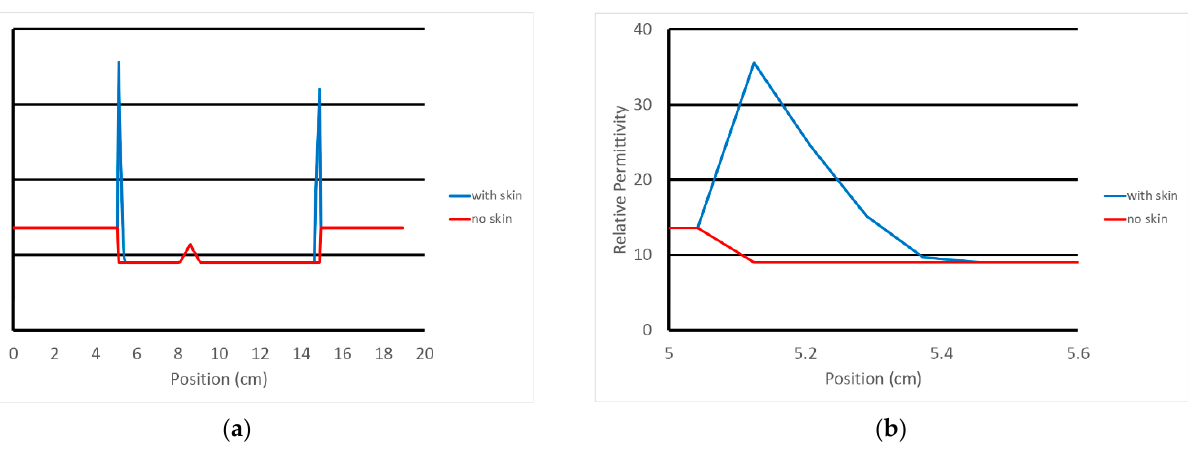
Figure 3. Graph of the relative permittivity along a single FDTD grid line through the breast: ( a ) transect across full domain, and ( b ) close-up in the vicinity of the left hand skin intersection, respec- tively.